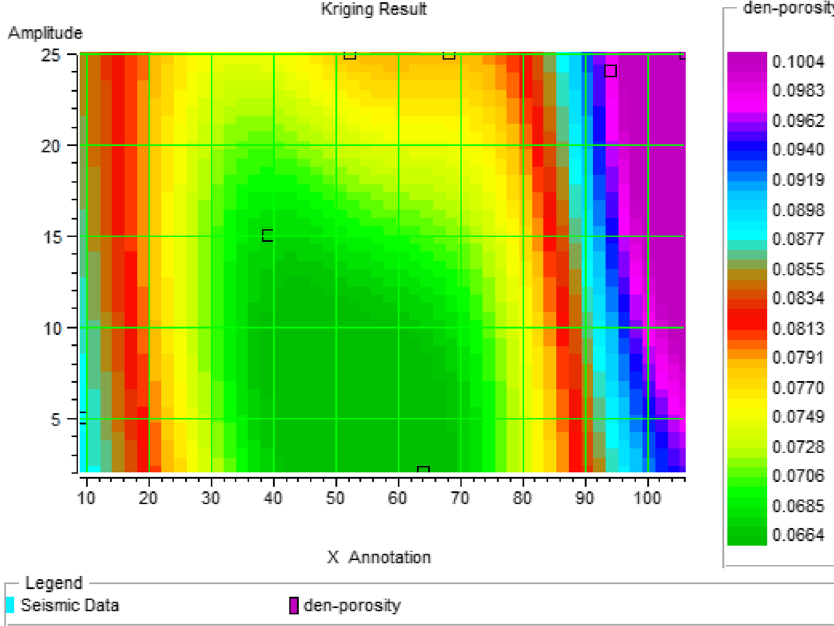
Fig. 25 Porosity obtained from ordinary kriging using structure obtained from well data in the second